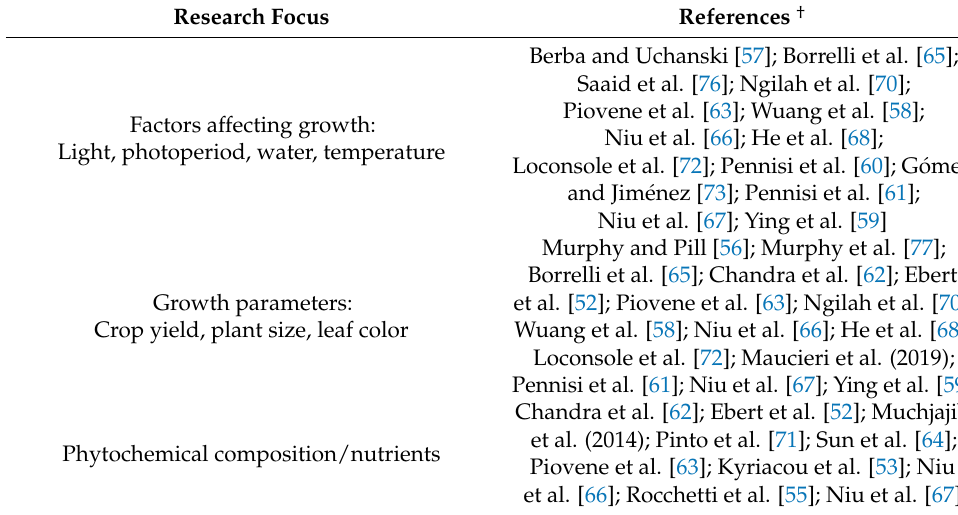
Table 7. The research focus of plant growth factors and parameters relevant to indoor vegetable production †